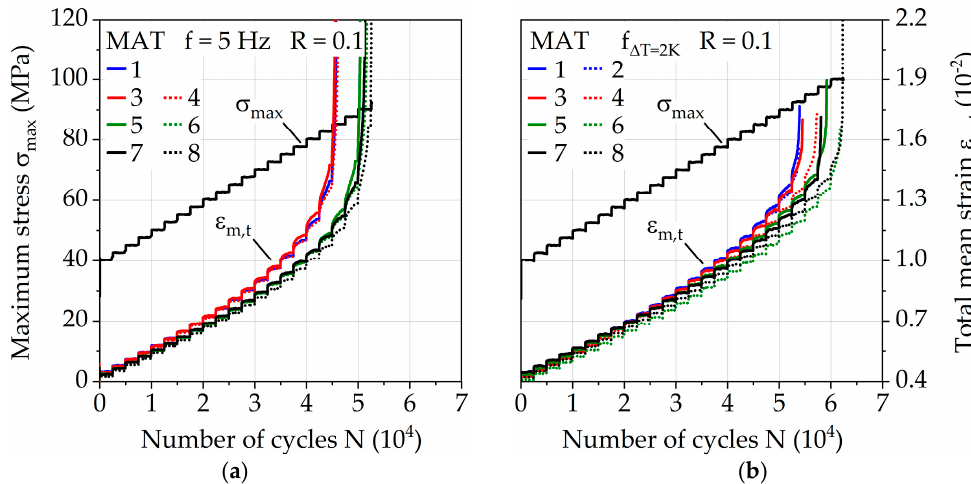
Figure 11. Total mean strain in multiple amplitude tests with ( a ) constant testing frequency of 5 Hz and ( b ) adjusted testing